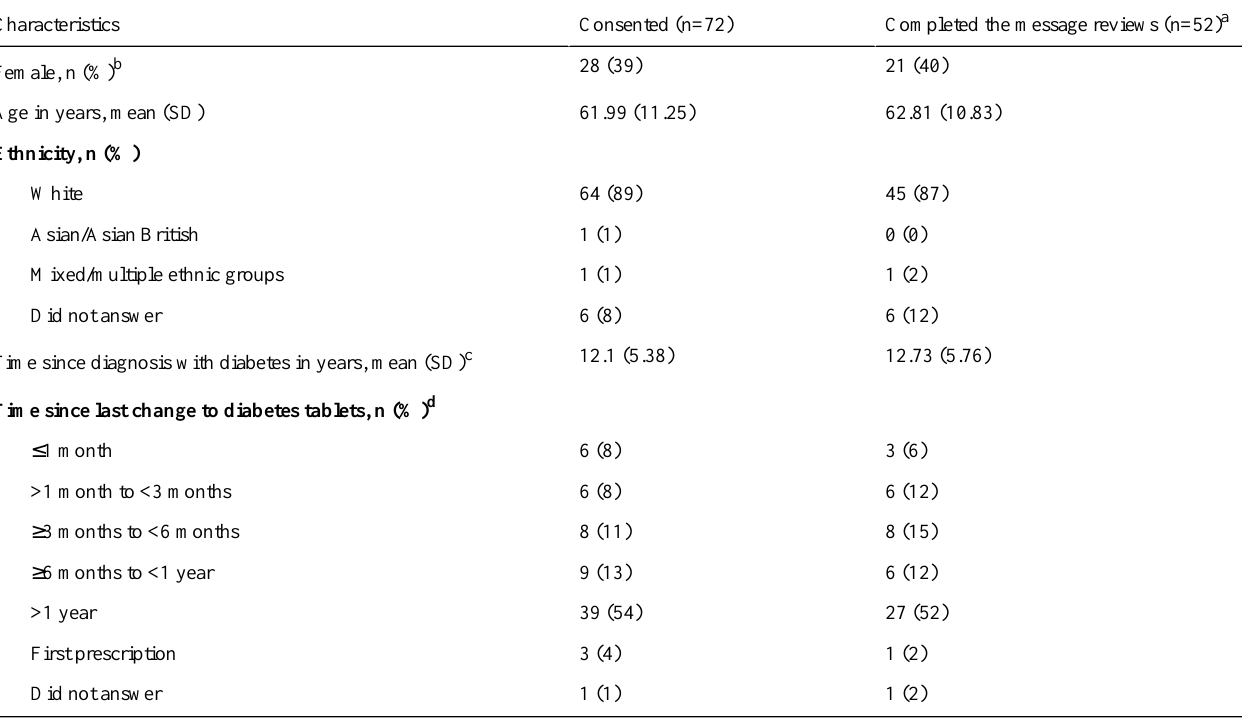
Table 3. Demographics and questionnaire responses for study 3